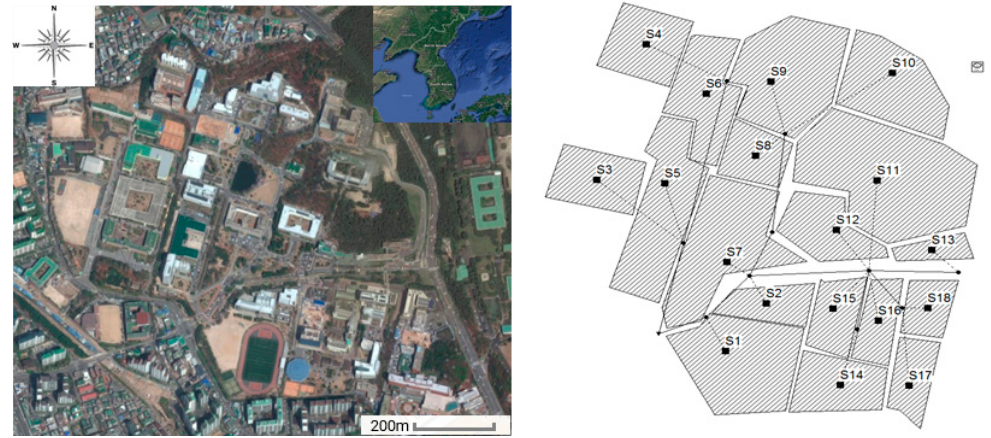
Figure 2. Model map of study region using the EPA’s SWMM. Table 2. Properties of sub-catchment in the Storm Water Management Model (SWMM) input file S i .